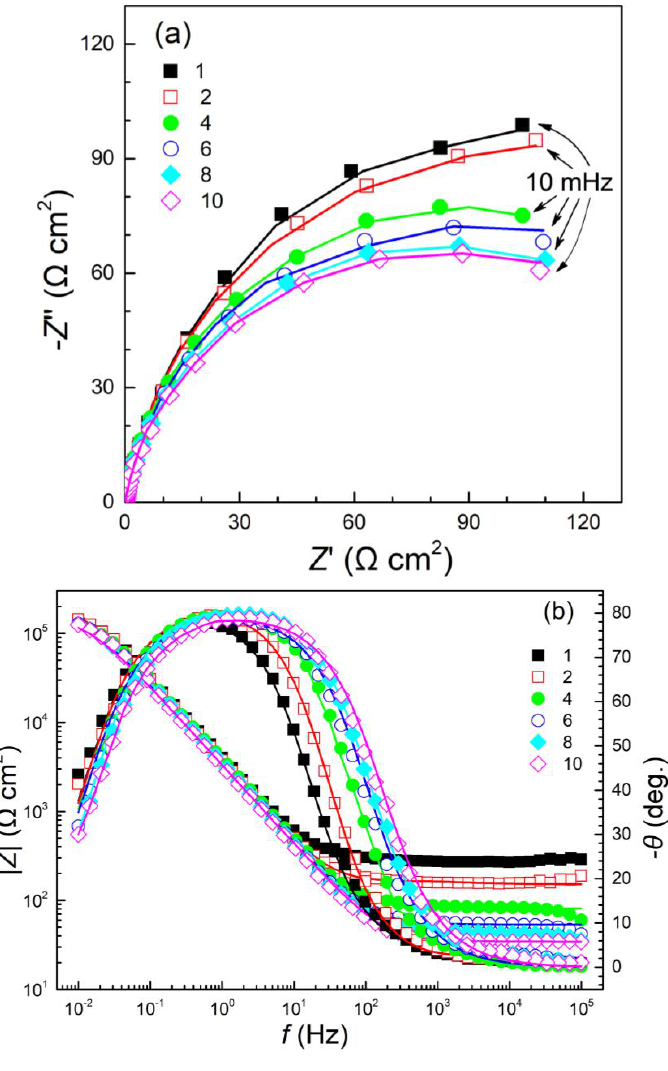
Figure 5. Impedance spectra ( a ) Nyquist and ( b ) Bode for specimens in the Ca 2+ and Mg 2+ -free solutions with different concentration ratios from 1 to 10 times. Symbols: experimental data; lines: fitted values.